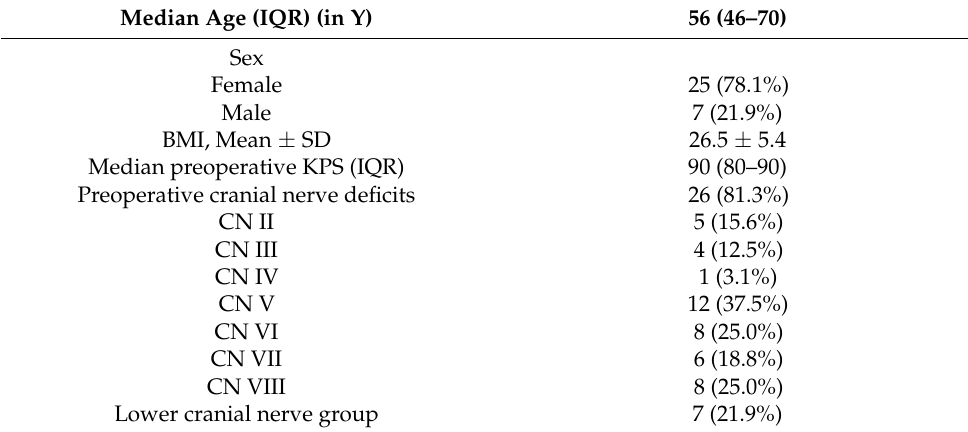
Table 1. Patient characteristics ( n =